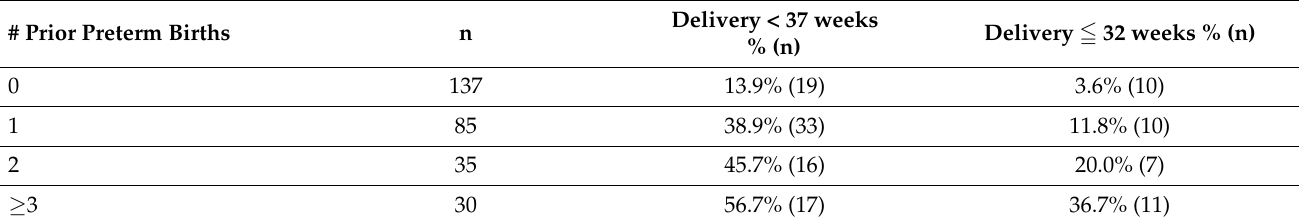
Table 3. Relationship of prior preterm birth with preterm birth in current